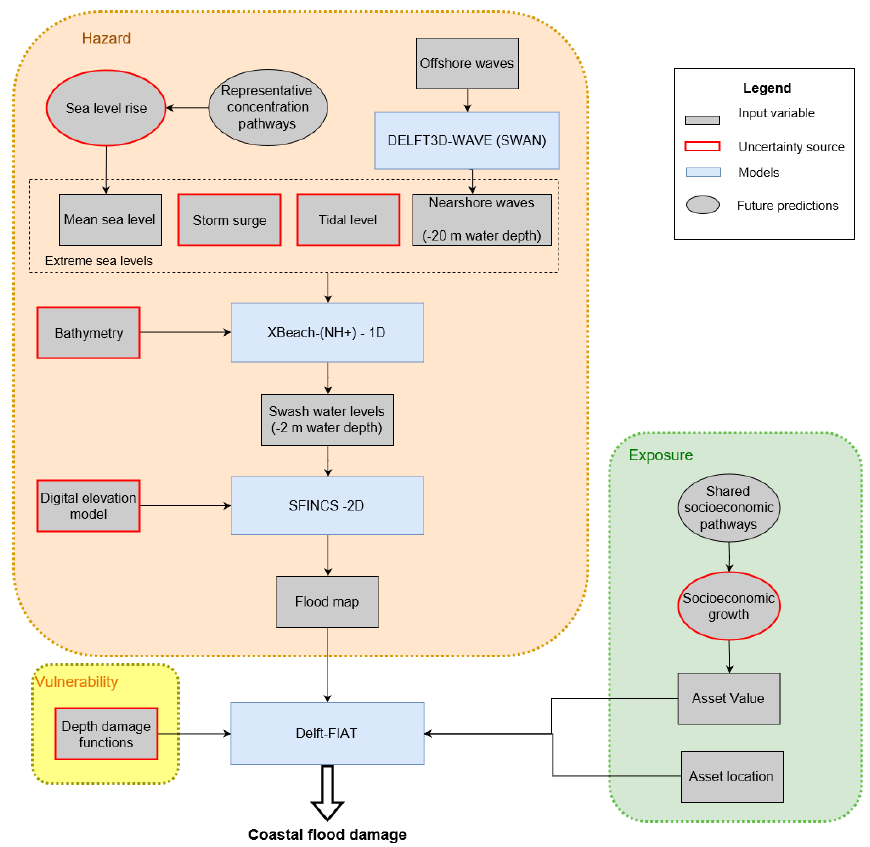
Figure 2. Schematic representation of the modelling chain used to carry out the damage assessment and including the different source of uncertainties analysed (red boxes). The blue rectangles show the numerical models (XBeach and SFINCS) and tools (Delft-FIAT). The inputs used to model the hazard, exposure and vulnerability are included in the orange, green and yellow boxes, respectively. Inputs used to model the present condition are represented with rectangles, whereas those used for future scenarios are represented with ellipses. Extreme sea levels are estimated by combining mean sea water levels, astronomical tides, storm surges and single waves. The earth surface is represented by bathymetric and digital elevation model (DEM) data. The inundation map produced by SFINCS is combined with depth damage functions (DDFs) and asset value to compute flood damages. Sea level rise (SLR) and socioeconomic growth are used to assess future predictions. Arrows indicate the data flow.